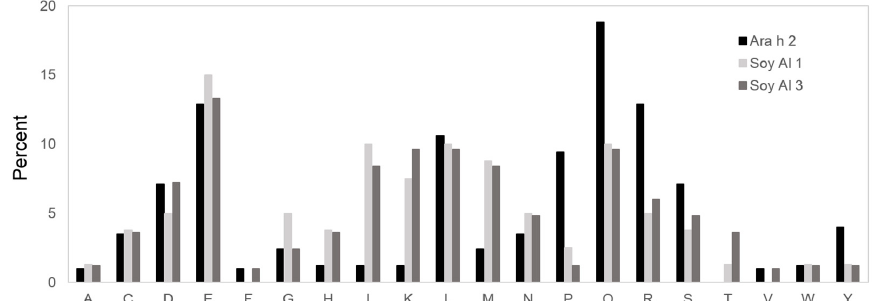
Figure 5. Amino acid comparison of the Ara h 2 epitope and homologous area with Soybean 2S albumins. The Y -axis of the graph represents the percentage of each amino acid in epitopes. A = alanine; C = cysteine; D = aspartic acid; E = glutamic acid; F = phenylalanine; G = glycine; H = histidine; I = isoleucine; K = lysine; L = leucine; M = methionine; N = asparagine; P = proline; Q = glutamine; R = arginine; S = serine; T = threonine; V = valine; W = tryptophan; Y = tyrosine.